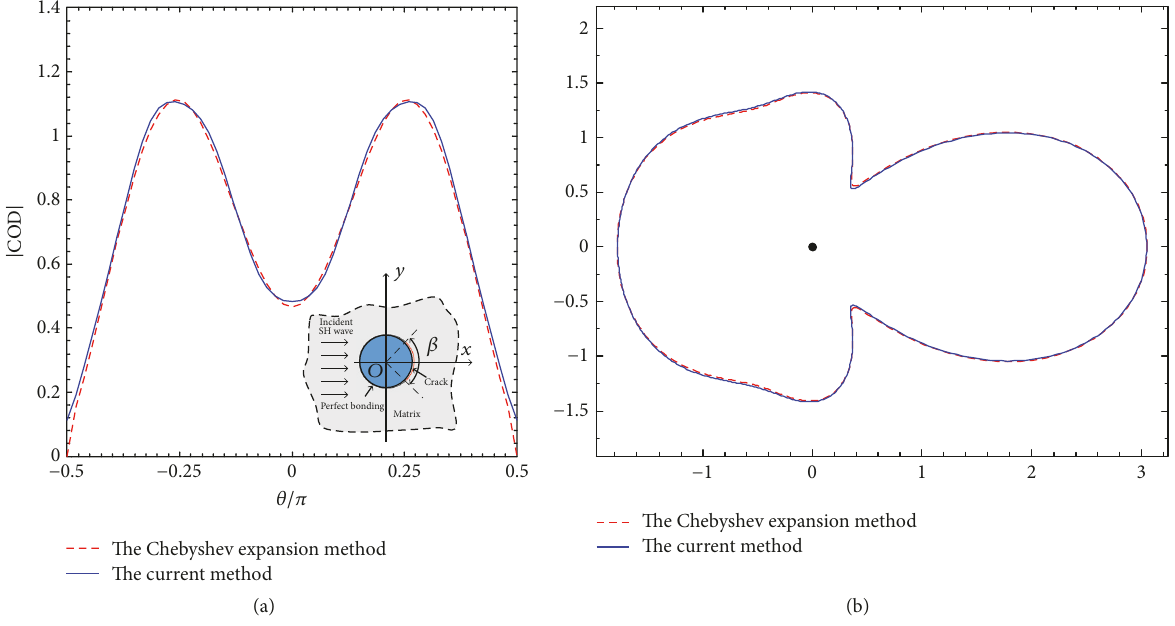
Figure 5: The calculated COD (a) and polar plot of the far-field scattering magnitude pattern (b) for the single scattering by a fiber with a partial debonding from the